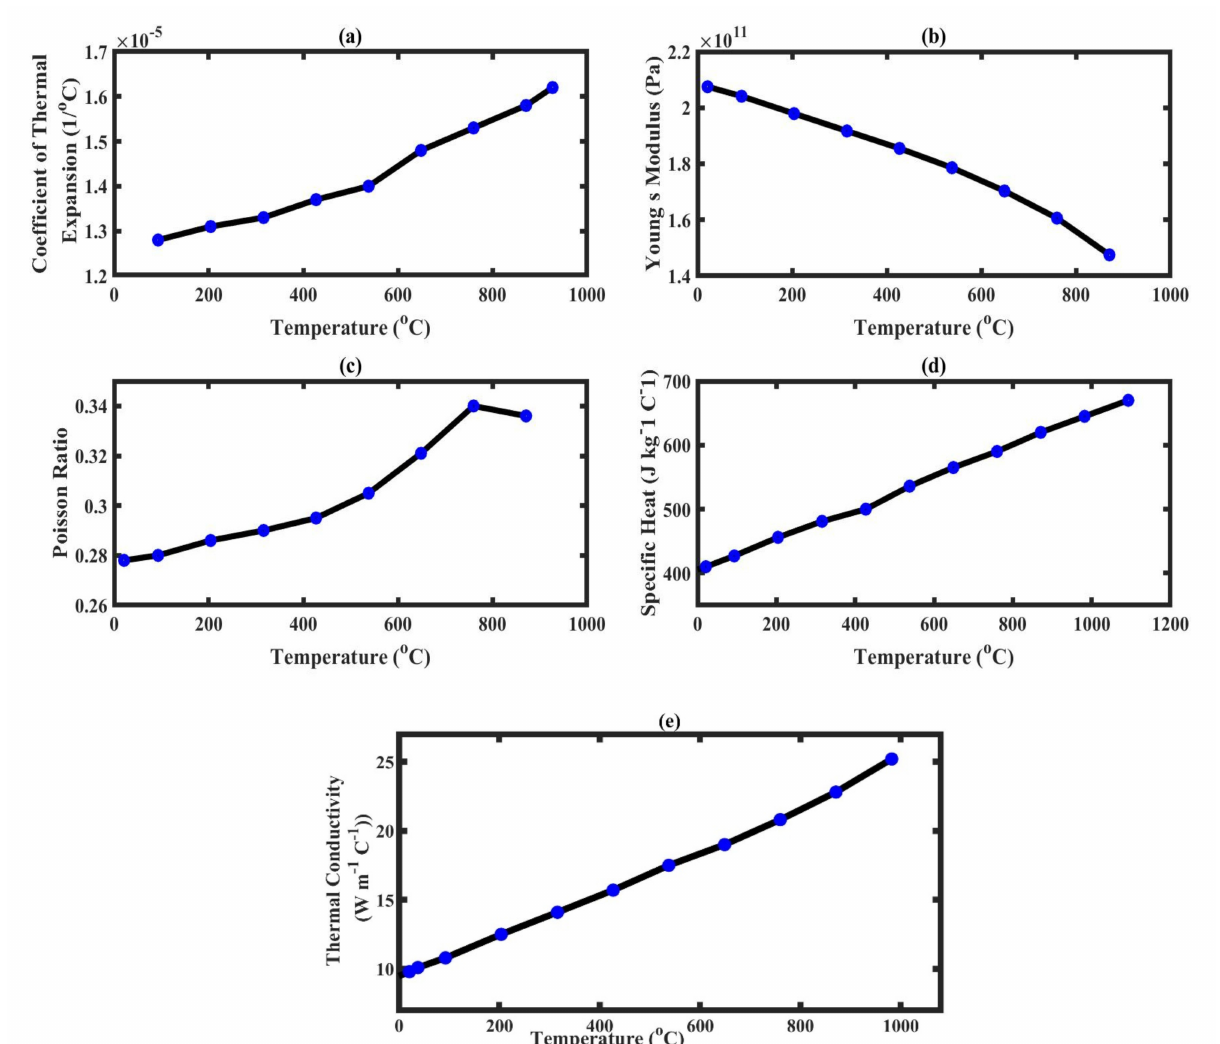
Figure 7. Material properties of IN625 (a Nickel alloy)